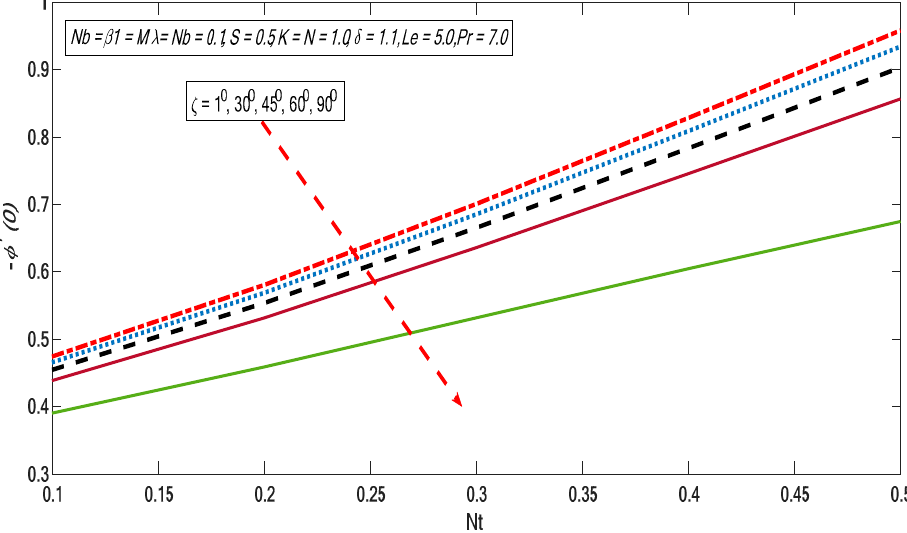
Figure 24. Variations of reduced Sherwood number with 𝑁𝑡 for different values of 𝜁 .